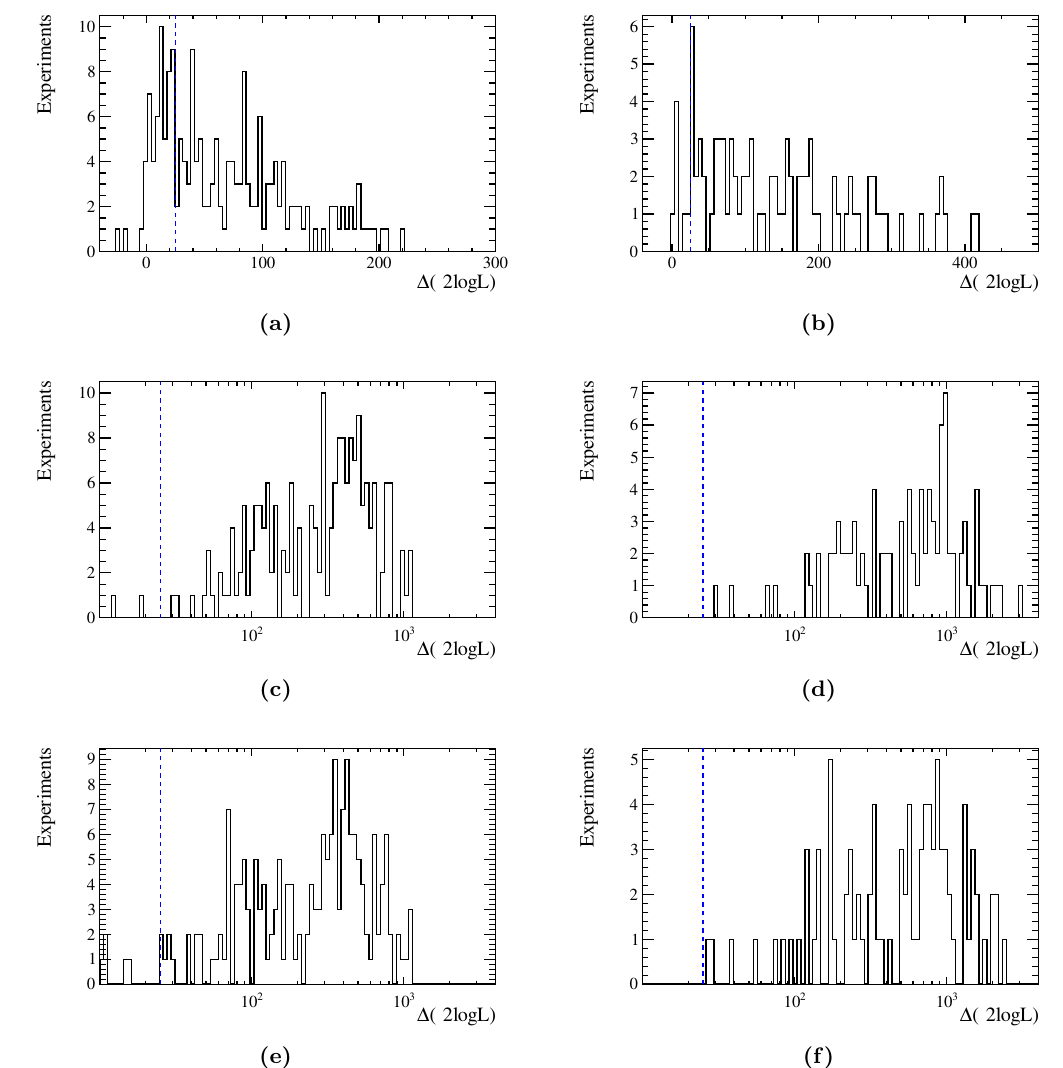
Figure 7 . Di(cid:11)erence in (cid:0) 2 log L between the two solutions for (cid:30) 00 LHCb shown on the left and 50 ab (cid:0) 1 at Belle II on the right. (a) and (b) represent the test with the LHCb a (cid:6) cut, (c) and (d) the case of no CP violation in B 0 ! (cid:26) 0 (cid:26) 0 , while in (e) and (f), (cid:30) 00 1 is set to the B 0 ! a + (cid:25) (cid:0) weak phase. The vertical dashed line indicates the cut-o(cid:11) at which a 5 (cid:27) 1 distinction is achieved. Note the log scale on the bottom four